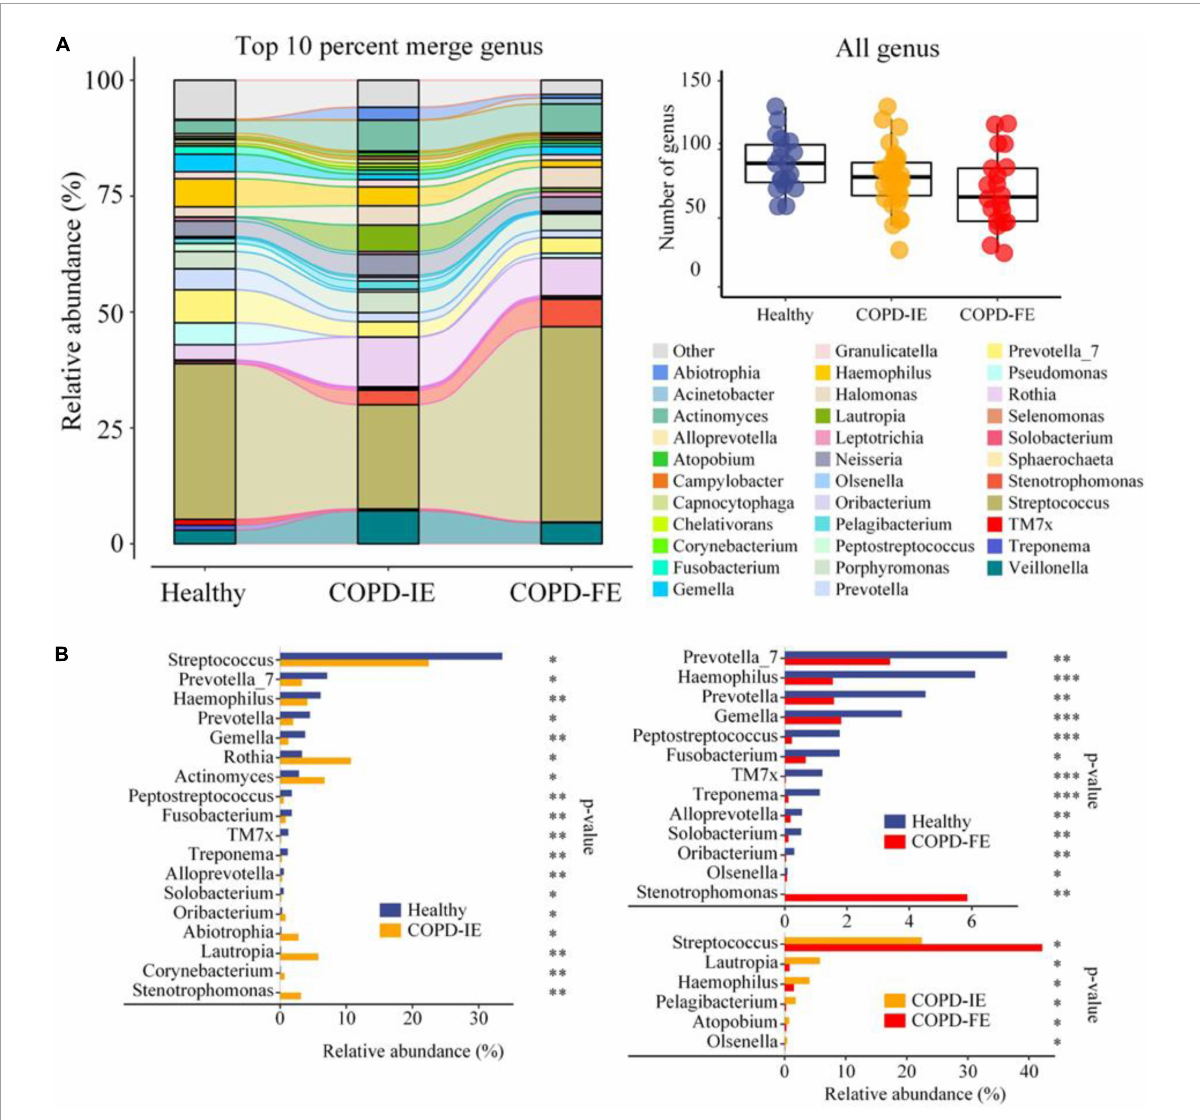
FIGURE4 Phylogenetic profiles of the sputum microbiome in healthy controls and chronic obstructive pulmonary disease (COPD) groups (COPD-IE and COPD-FE). (A) Average compositions and relative abundance of the bacterial community in each group at the genus level (top 10% in each group). The inset shows a box plot summarizing the distributions of the numbers of all genera detected for different groups. (B) Differentially distributed genera between groups. ∗ p < 0.05; ∗∗ p < 0.01; ∗∗∗ p <